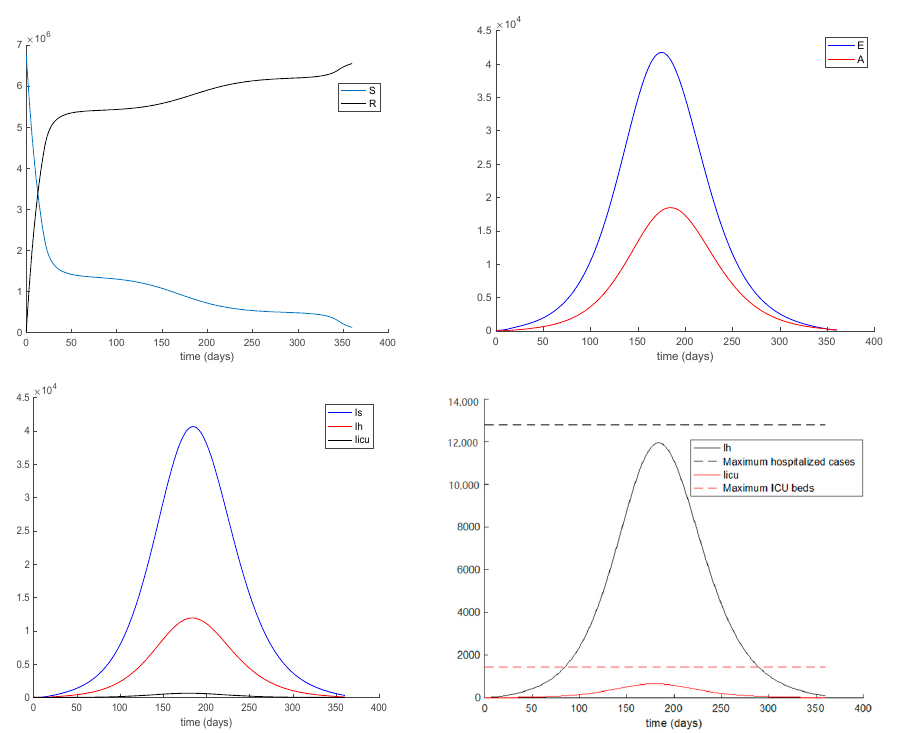
Figure 8. Evolution of all population when Programme 6 is employed with β being a control variable.